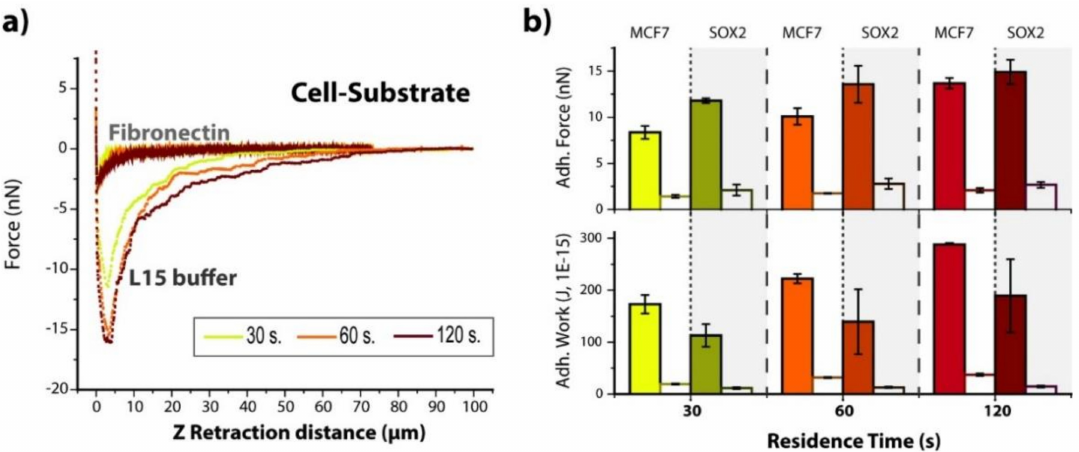
Figure 4. Influence of soluble fibronectin. ( a ) Representative force–distance plots for Sox2 cells interacting with Fibronectin substrates in L15 medium either with or without fibronectin addition, and increasing contact times (30, 60 and 120 s). ( b ) Calculated values of maximum adhesion force and adhesion work for both MCF7 and Sox2 cells before (filled columns, values from Figure 2) and after (empty columns) the injection of soluble